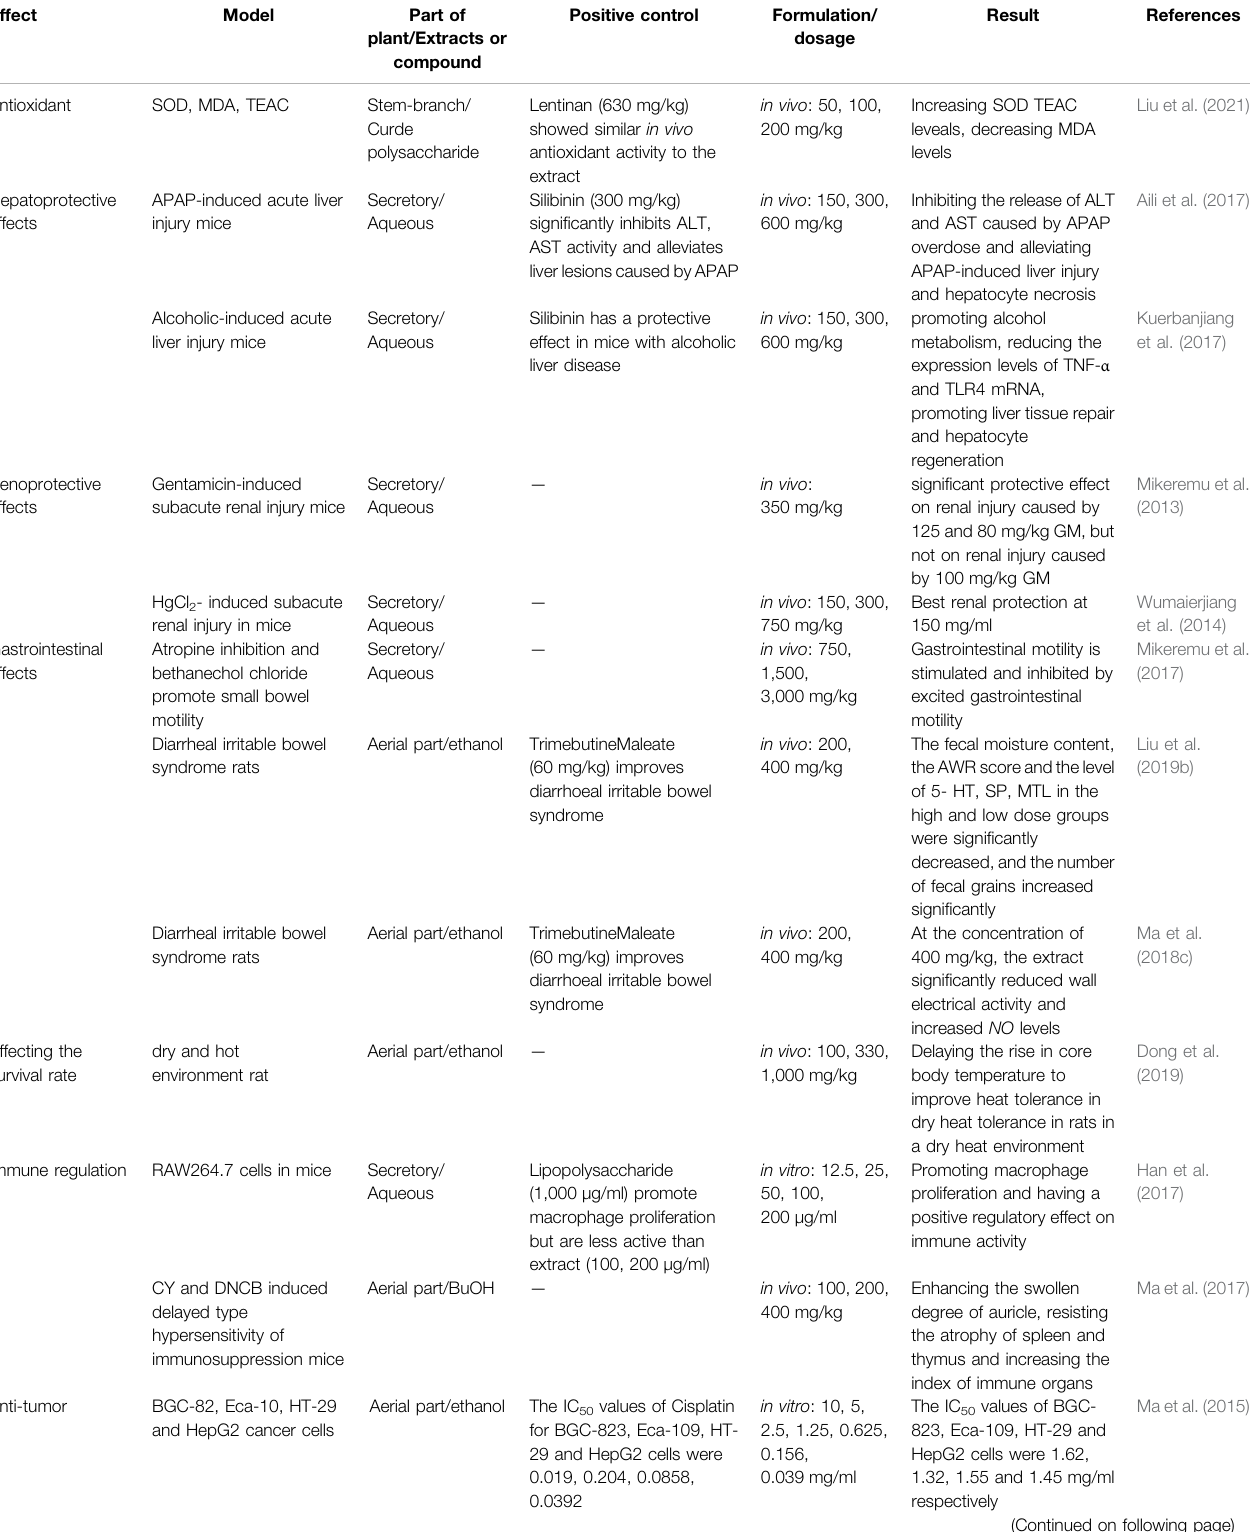
TABLE 3 | Modern Pharmacological studies of A. sparsifolia